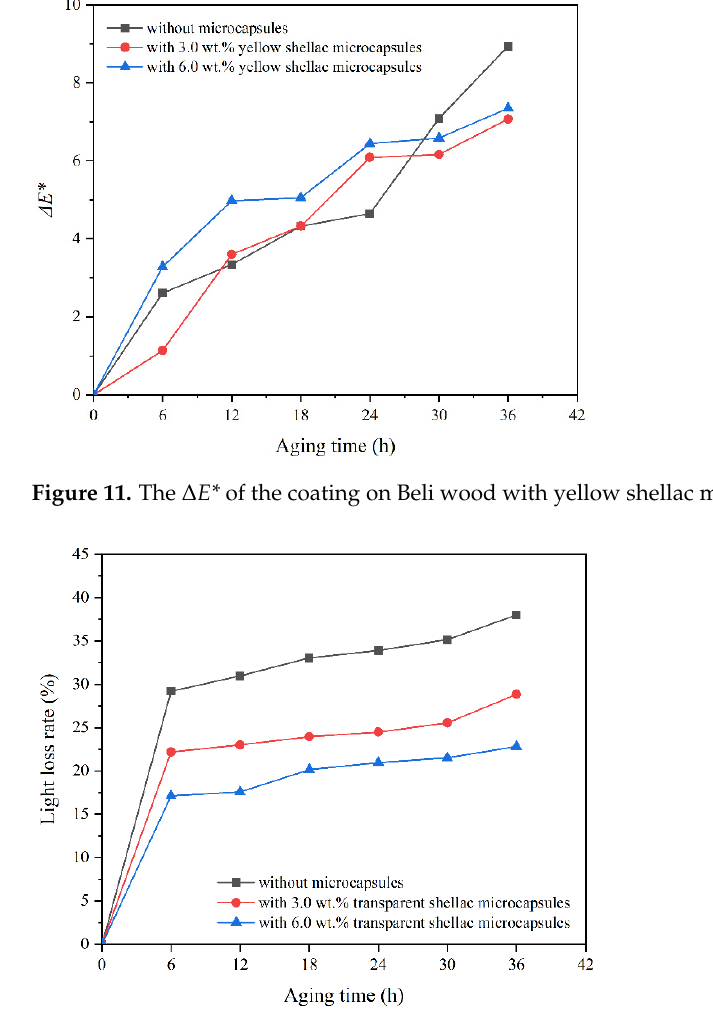
Figure 12. The light loss rate of the coating on Beli wood with transparent shellac microcapsules after aging.